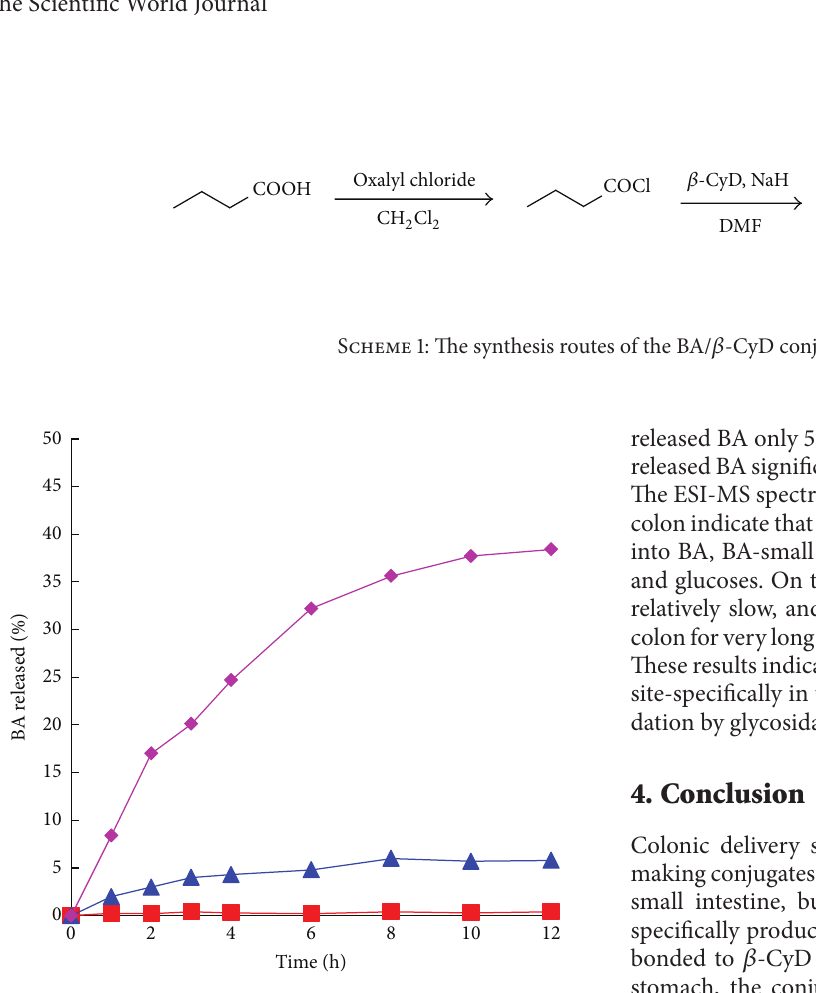
Figure 2: The release behaviors of BA from the BA/ 𝛽 -CyD conju- gates incubated with rat gastrointestinal tract contents (17%,